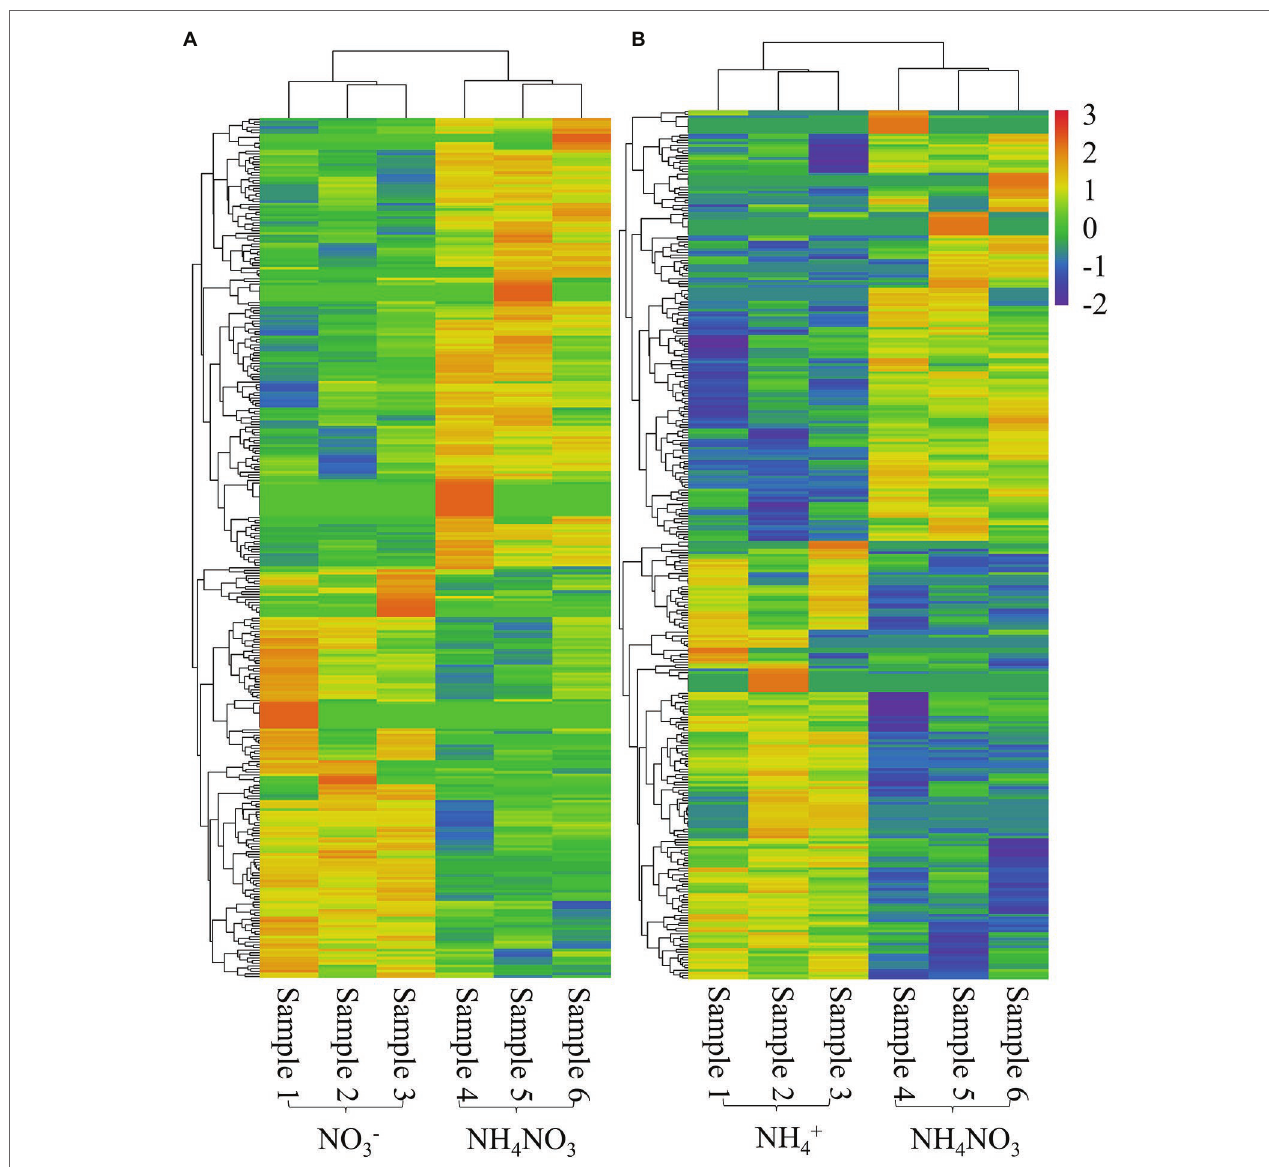
FIGURE 3 | Heatmap of significantly differentially expressed lncRNAs with |log 2 (fold change)| > 1 and P value < 0.05 in the NO 3- vs. NH 4 NO 3 (A) and NH 4+ vs. NH 4 NO 3 (B) comparisons of P. x